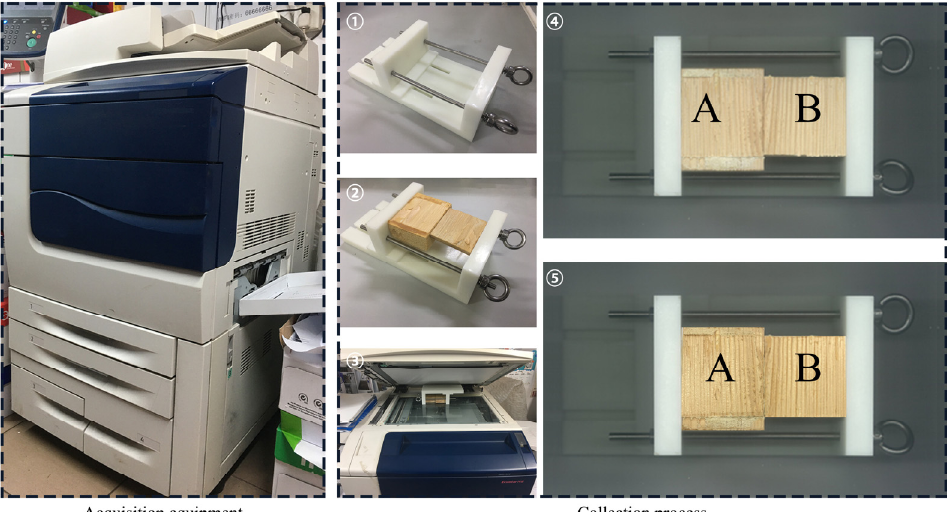
Figure 2. WFSI acquisition equipment and process: ① : Fixture; ② : The specimen is placed in the fixture with the two glued damaged sides up; ③ : Place the fixture on the table of the scanning in- strument; ④ : Acquired scanned image; ⑤ : After color correction; A: Specimen length of 60 mm side of the gluing damage surface; B: Specimen length of 60 mm side of the gluing damage surface.